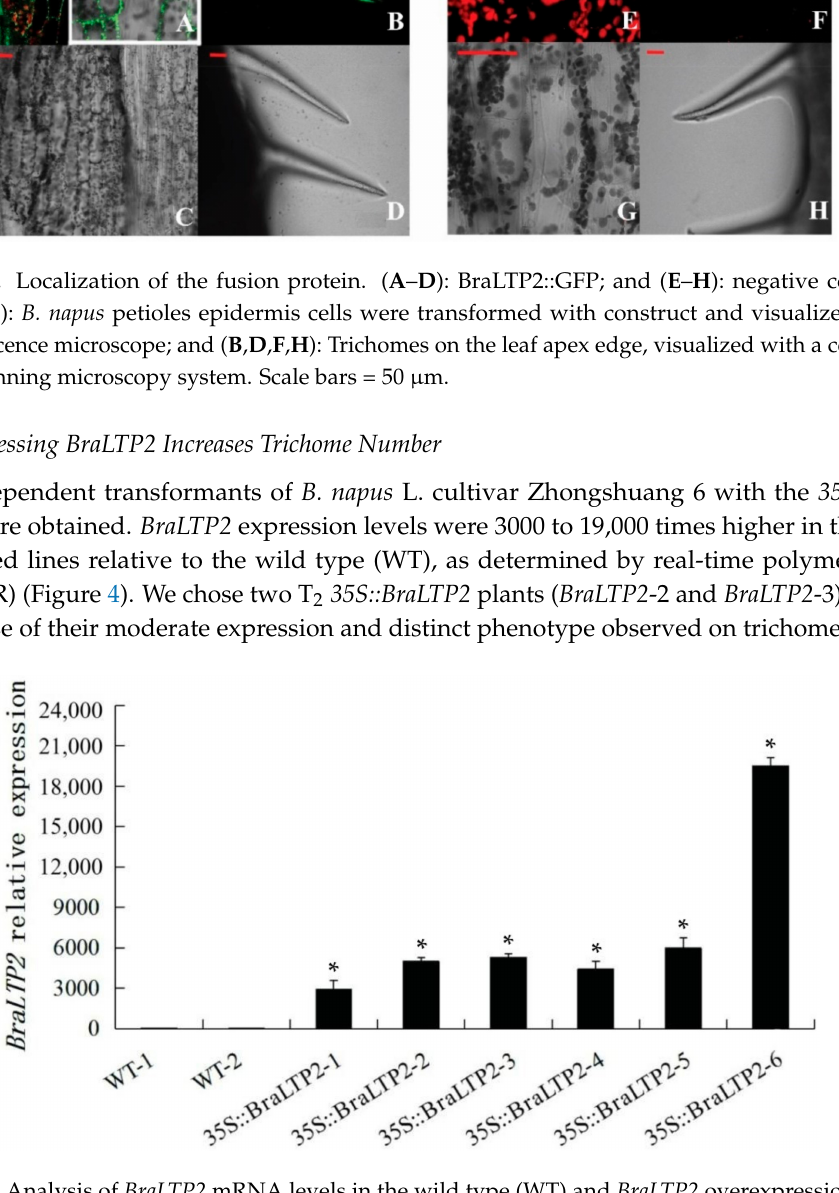
Figure 4. Analysis of BraLTP2 mRNA levels in the wild type (WT) and BraLTP2 overexpression lines. BraLTP2 mRNA levels in 10-week-old wild type (WT) and 35S::BraLTP2 transgenic plants by real-time polymerase chain reaction (PCR). Actin was used as an internal loading control in the y -axis. Standard errors were derived from three biological repeated experiments for the expression levels of each T 0 plant. * Statistically significant difference from wild type ( * p <